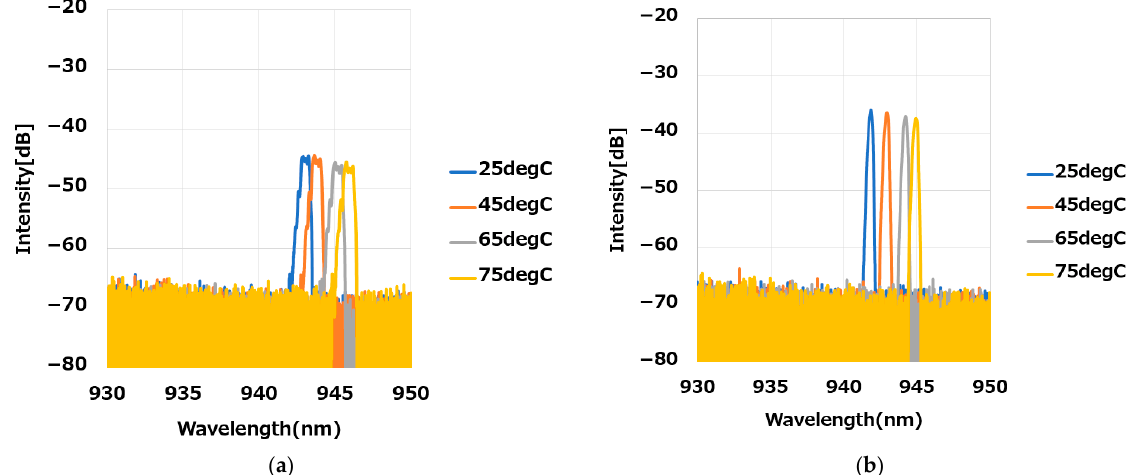
Figure 10. Output spectra of the SS-VCSEL on the Tx module at different temperatures under ( a ) one-block and ( b ) all-blocks emissions.